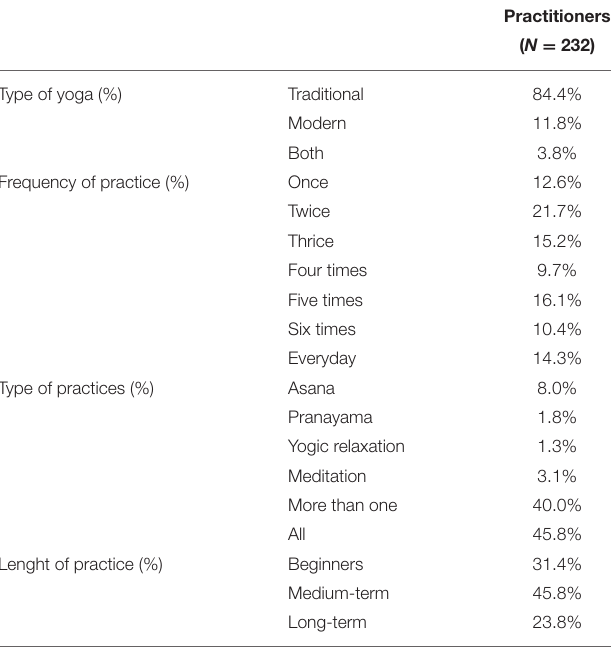
TABLE 1C | Differences in percentages among yoga practitioners on aspects of yoga practice.